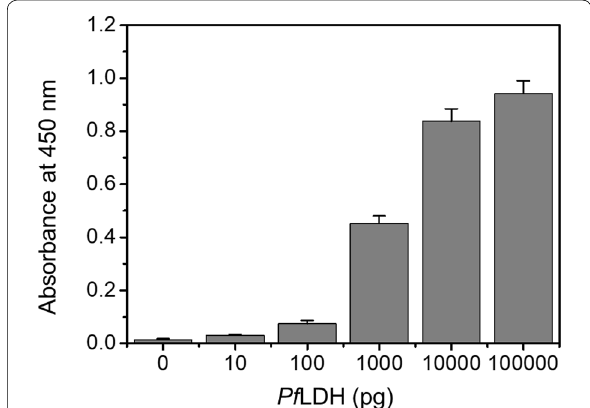
Fig. 2 Diagnosis of Pf LDH using the ELISA. The optical density were